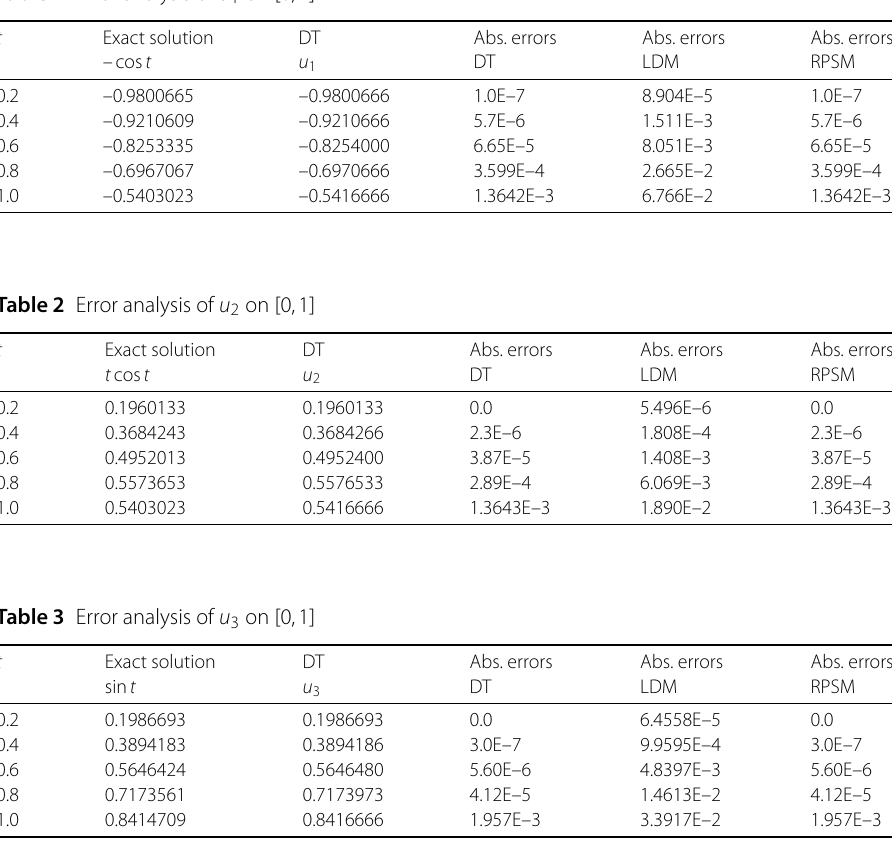
Table 1 Error analysis of u 1 on [0,1]